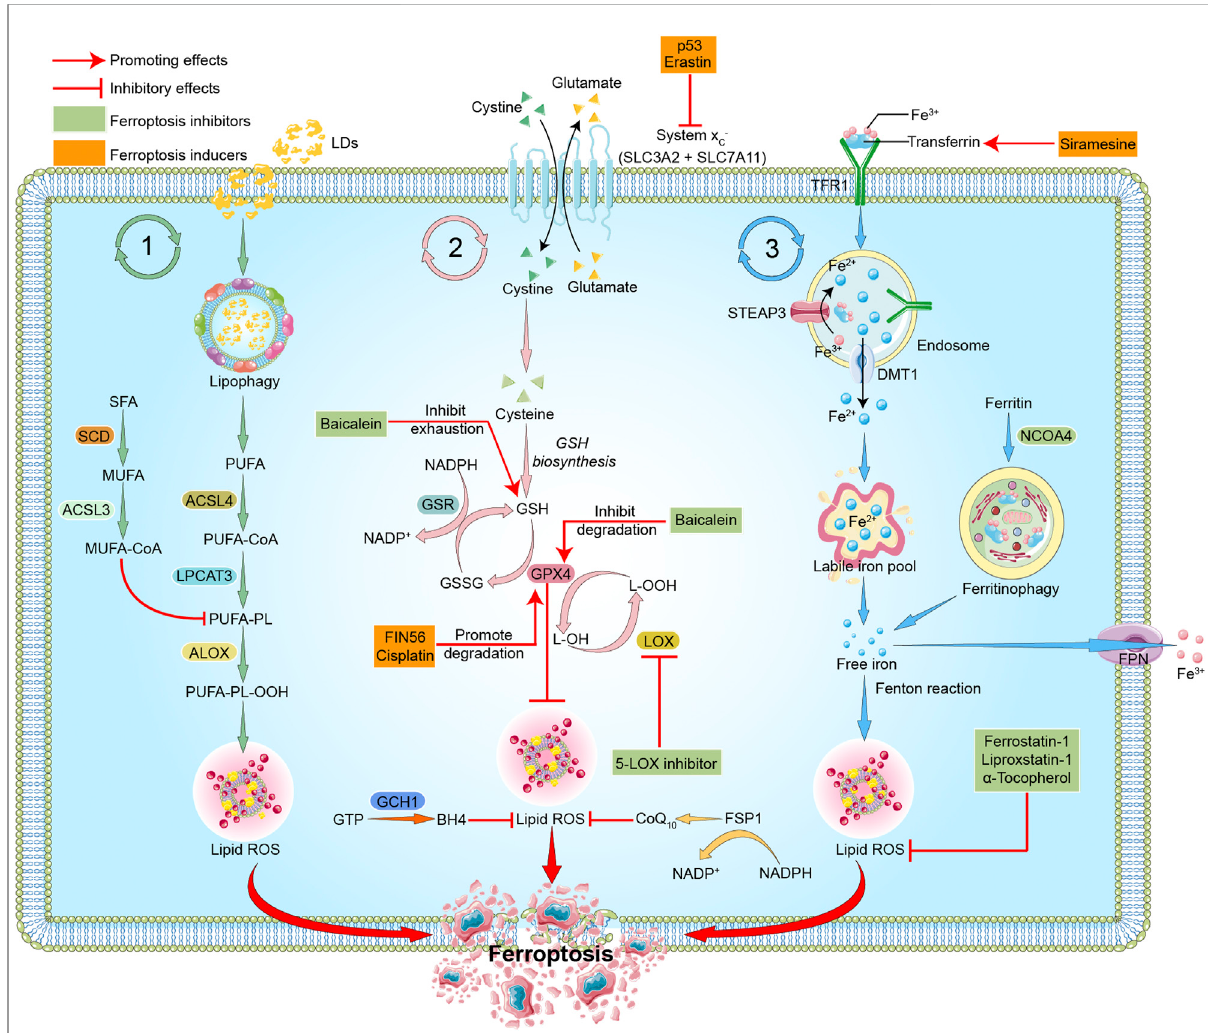
Mechanisms of ferroptosis. The three pathways represent lipid metabolism, antioxidant metabolism, and iron metabolism in ferroptosis, respectively. In lipid metabolism, LDs are degraded via lipophagy to release free fatty acids, including PUFAs. Accumulated PUFAs are catalyzed by ACSL4togeneratethekeysubstratePUFA-CoA,whichis fi nallyesteri fi edintoPUFA-PLsbyLPCAT3.PUFA-PLscanbeperoxidizedtoPUFA-PL-OOH through enzymatic and non-enzymatic lipid peroxidation reactions in the presence of bioactive iron. PLOOH can generate lipid hydroxyl radicals and lipid peroxyl radicals, sensitizing the cell to ferroptosis. MUFAs, likely through MUFA-PLs from MUFA-CoA, can inhibit PUFA-PLs by replacing PUFA from phosphatidylethanolamine, thus reducing the available substrate for lipid peroxidation. In antioxidant metabolism, the two subunits SLC3A2 and SLC7A11 constitute the system Xc-, which is an amino acid antiporter that mediates the exchange of extracellular cystine and intracellular glutamate across the plasma membrane. After entering the cells, cystine is reduced to cysteine and participates in the synthesis of GSH, which serves the substrate of GPX4. GPX4 reduces cytotoxic lipid peroxide (L-OOH) to the corresponding alcohol (L-OH), thus inhibiting the formation of lipid peroxide and ferroptosis. GPX4 can also transform GSH into GSSG, and GSSG can be reduced to GSH under the action of GSR. FSP1-CoQ10 or GCH1-BH4 pathway inhibits ferroptosis independently of GSH. In iron metabolism, ferric iron (Fe 3+ ) is bound to transferrin (TF) to form TF-Fe 3+ , which is then taken up by the TF receptor (TFR1). In endosomes, STEAP3 reduces Fe 3+ to Fe 2+ , which is then released to cytoplasm through DMT1, and stored in LIP or ferritin. Fe 2+ mediates the Fenton reaction, thereby promoting lipid peroxidation and ferroptosis. Excess Fe 2+ is oxidized to Fe 3+ by FPN. In addition, NCOA4-mediated ferritinophagy can increase LIP, thereby sensitizing the cell to ferroptosis through Fenton reaction. The target of ferroptosis inducers and inhibitors are also indicated. P53 and erastin can interfer with the synthesis of GSH by inhibiting system Xc-. FIN56 and cisplatin promote the degradation of GPX4. Siramesine increases the expression of transferrin in iron metabolism and increases the level of intracellular ferric iron. Baicalein inhibits GSH depletion, GPX4 degradation and lipid peroxidation. 5-LOX inhibitor inhibits the production of ROS. Ferrostatin-1, Liproxstatin-1, and α -Tocopherol scavenge ROS and inhibit lipid peroxidation. Red arrows indicate promoting effects. Short lines with vertical end indicate inhibitory effect. The pink ball represents Fe 3+ . Blue balls represent Fe 2+ . Green triangles represent cystine. Yellow triangles represent glutamate. Light green triangles represent cysteine. Green boxes indicate ferroptosis inhibitors. Yellow boxes represent ferroptosis inducers. Abbreviations: ACSL3, acyl-CoA synthetase long chain family member 3; ACSL4, acyl-CoA synthetase long chain family member 4; ALOX, arachidonate lipoxygenase; BH4, tetrahydrobiopterin; CoA, coenzyme A; CoQ10, coenzyme Q10; DMT1, divalent metal transporter 1; FPN, ferroportin; FSP1, ferroptosis suppressor protein 1; GCH1, GTP cyclohydrolase 1; GPX4, glutathione peroxidase 4; GSH, glutathione; GSR, glutathione reductase; GSSG, oxidized glutathione; GTP, guanosine triphosphate; LDs, lipid droplets;